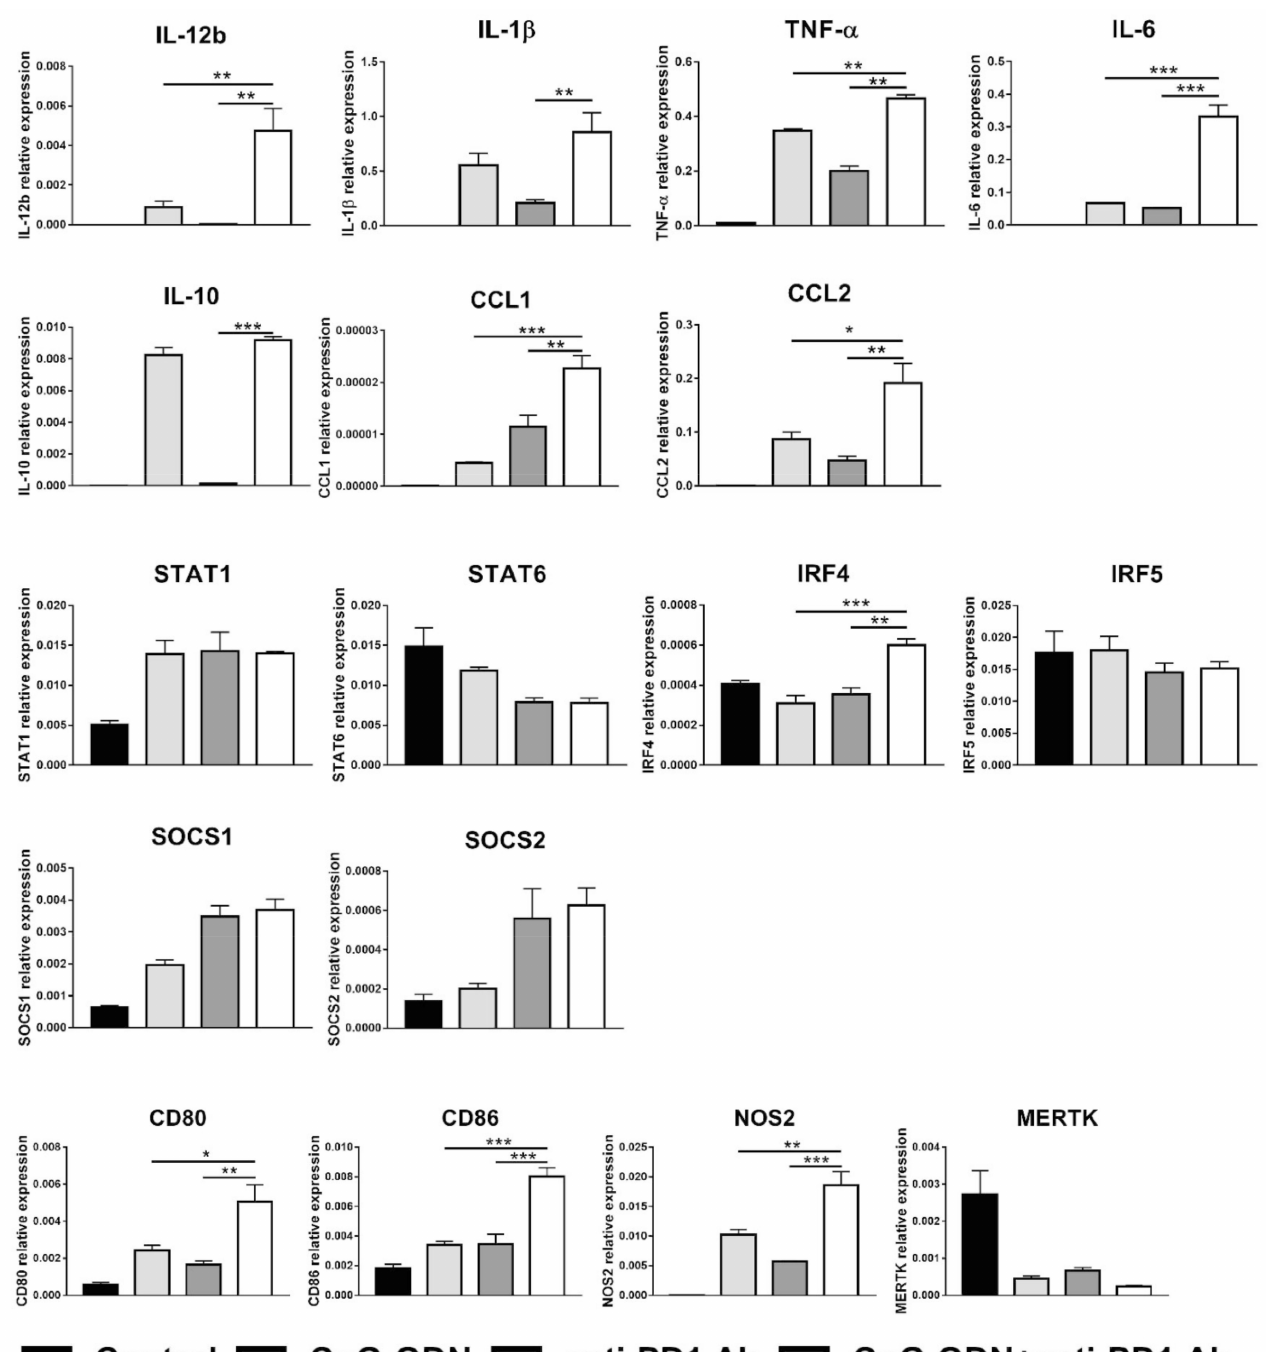
Figure 4. Effect of the combination of CpG-ODNs and an anti-mouse PD-1 antibody on RAW264.7 macrophages in vitro. RAW264.7 macrophages were seeded in 12-well plates and then stimulated with 1 µ M CpG-ODNs and 10 µ g/mL anti- mouse PD-1 antibody alone or in combination for 6 h. Controls were left untreated. At the end of treatment, mRNA was extracted, and real-time PCR was performed. The data were normalized to the expression of β 2m as a housekeeping reference gene and analyzed by the comparative 2 − ∆ Ct method. The data are presented as the mean ± SEM. * p < 0.05, ** p < 0.01, and *** p < 0.001 by one-way ANOVA followed by Tukey’s multiple comparison test with a single pooled variance or by the Kruskal–Wallis test followed by Dunn’s multiple comparison test for nonparametric data. CpG-ODNs: CpG oligodeoxynucleotides; anti-PD-1 Ab: anti-PD-1